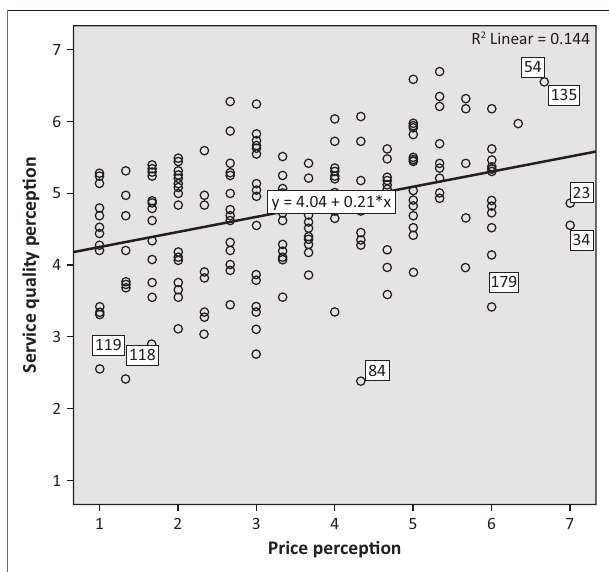
FIGURE 1: Scatterplot of service quality perception and price perception. TABLE 12: Results of Spearman’s rho rank-order correlation test. Overall price